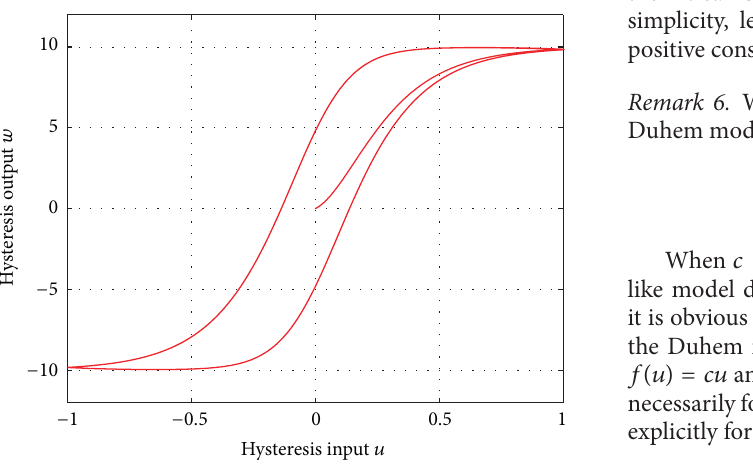
Figure 2: Hysteresis curves described by 𝜆(𝑢) = 10 tanh 5𝑢 .